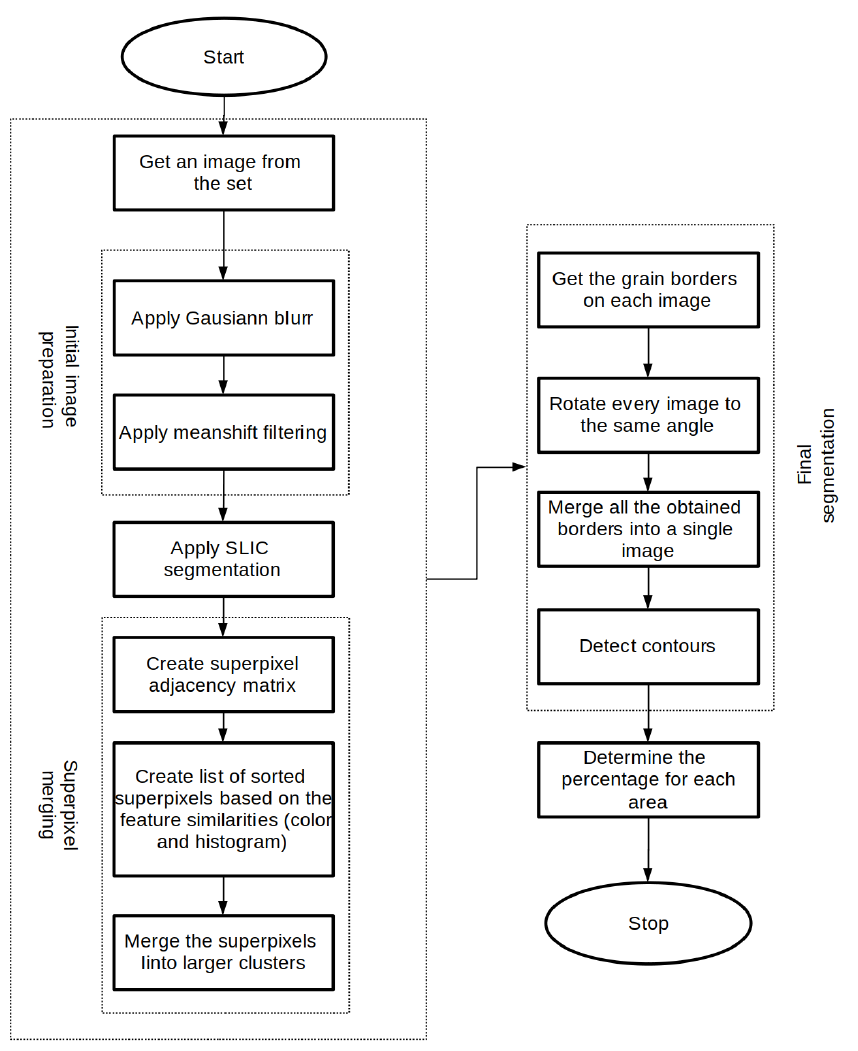
Figure 3. Flow-chart of the